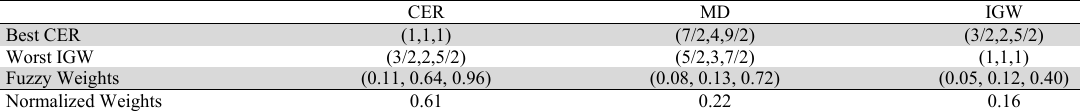
Best-Worst value for the Sub-group 1 (Climatic)